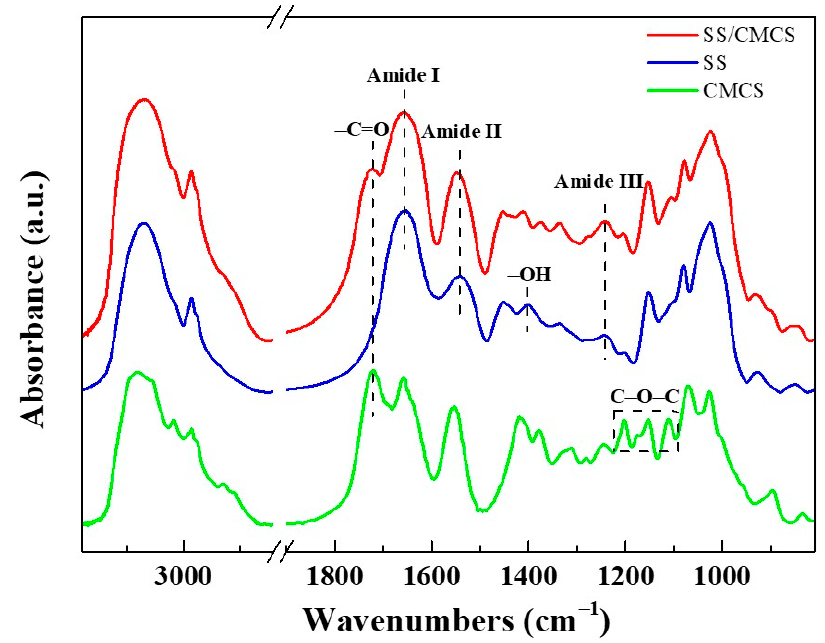
Figure 1. The FTIR spectra for freeze-dried SS solution, CMCS hydrogel and SS/CMCS hydrogel.